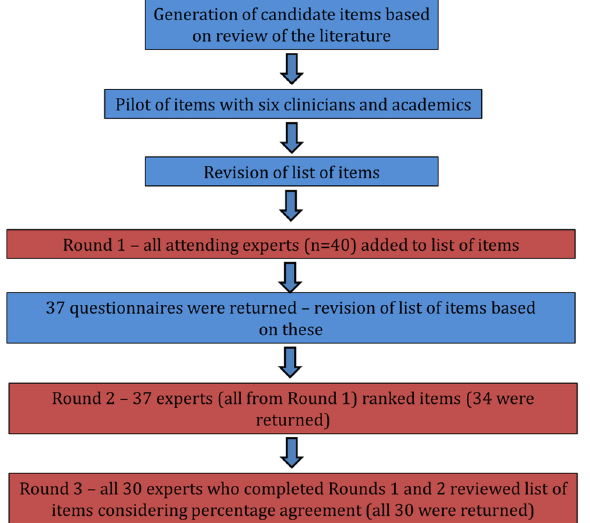
Figure 1. Flow-diagram of the three-stage modified Delphi process.